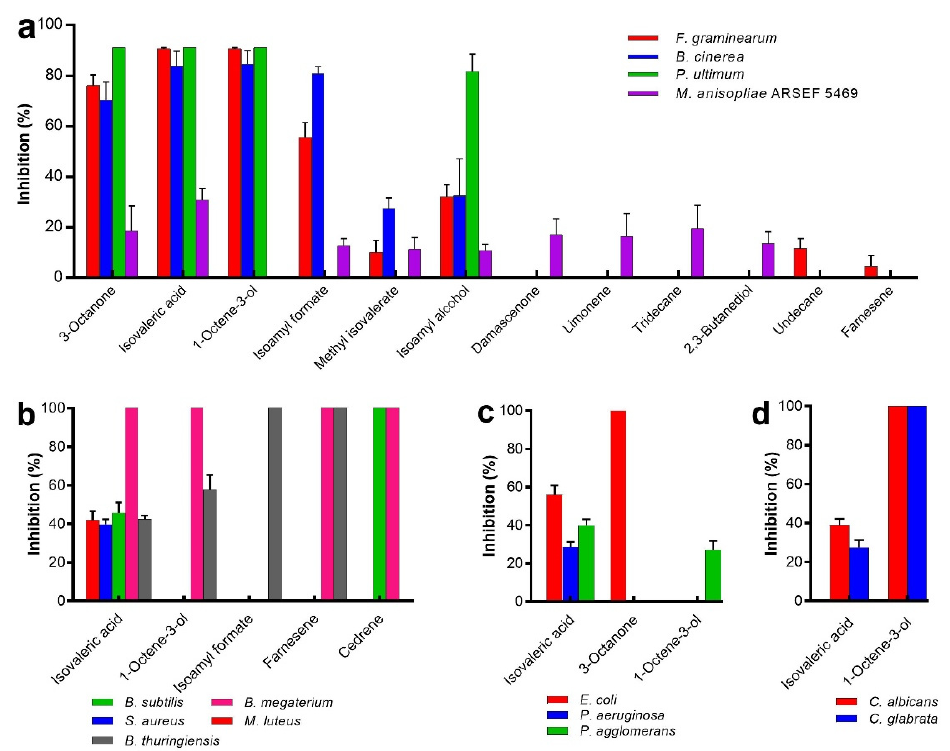
Figure 2. Inhibition (%) of growth of ( a ) filamentous fungi, ( b ) G+ bacteria, ( c ) G − bacteria and ( d ) yeasts when exposed to VOCs. The bacteria and yeasts were examined 24 h post-exposure (to 10 µL VOC) and the filamentous fungi 5 days post-exposure. Values represent mean (±SD) of two experiments, each with 4 technical replicates per treatment.